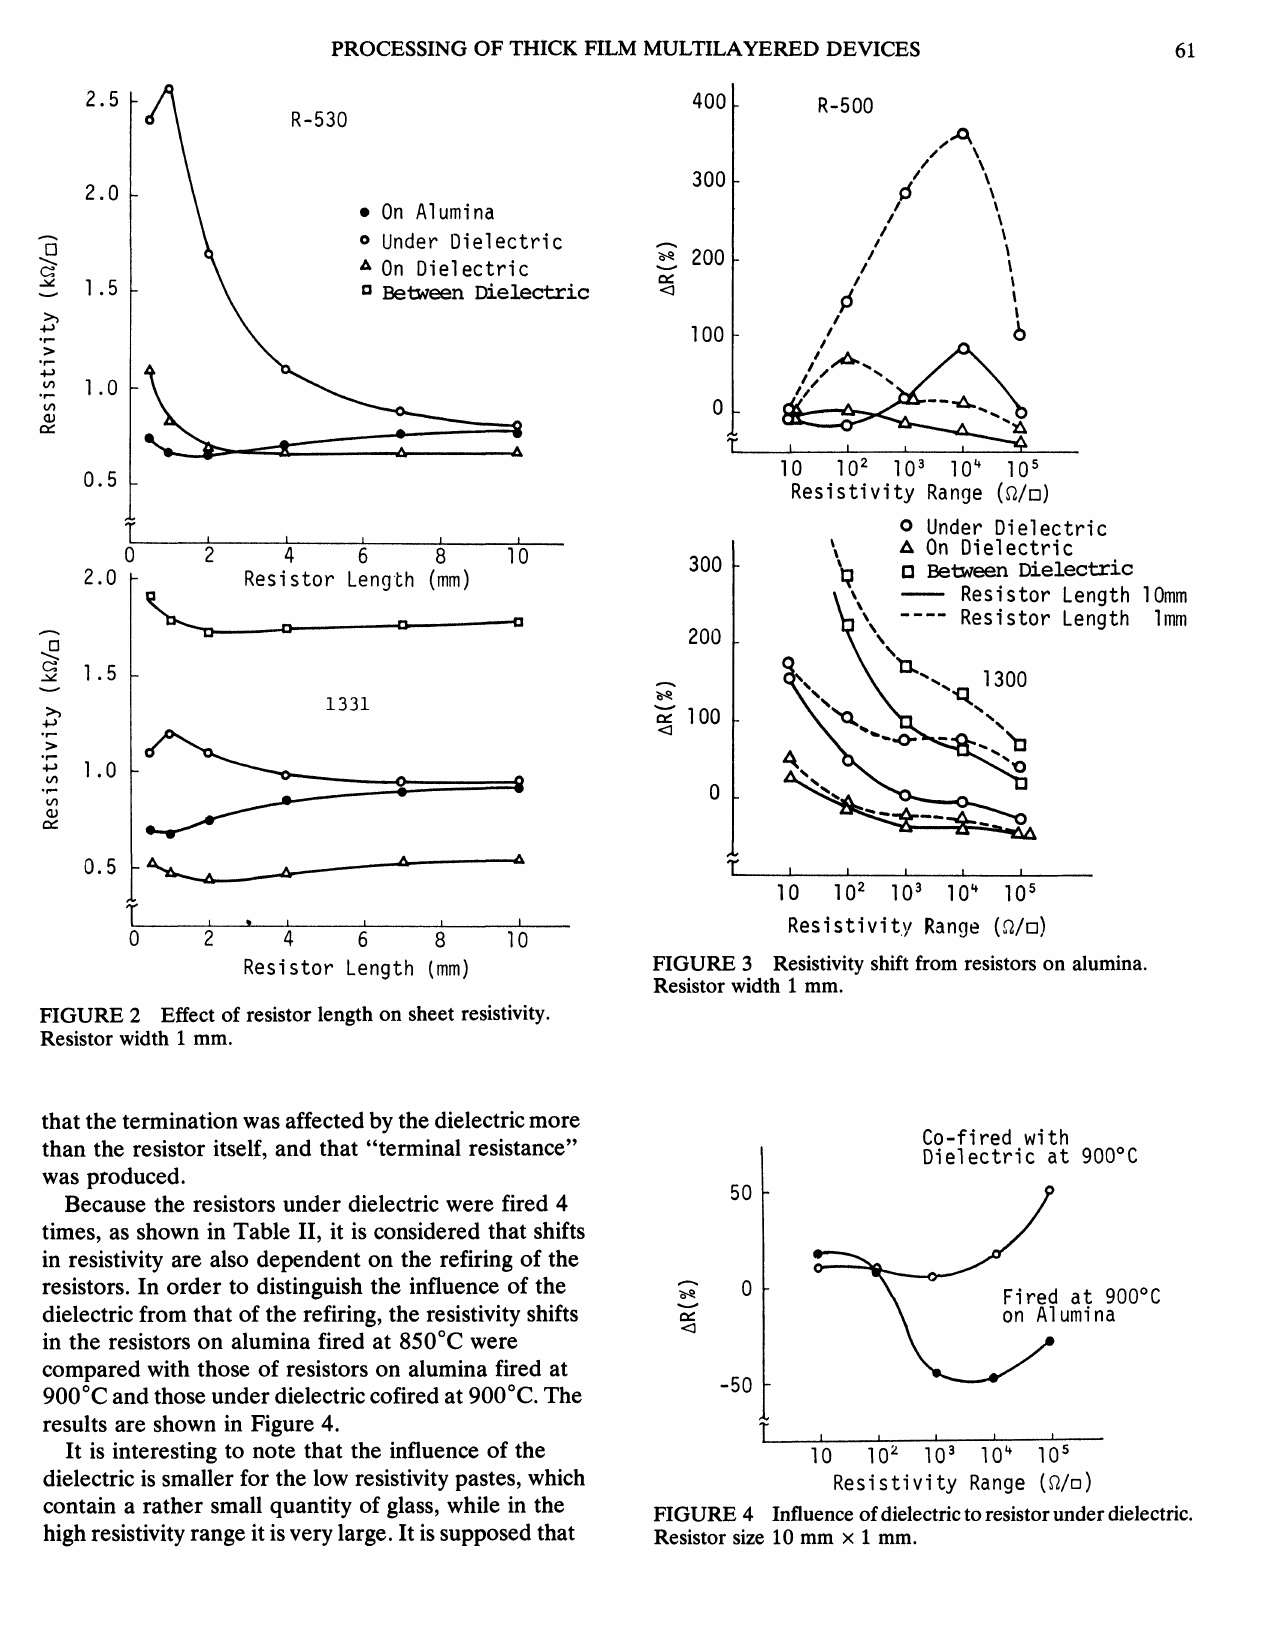
FIGURE 2 Effect of resistor length on sheet resistivity. Resistor width 1 mm.